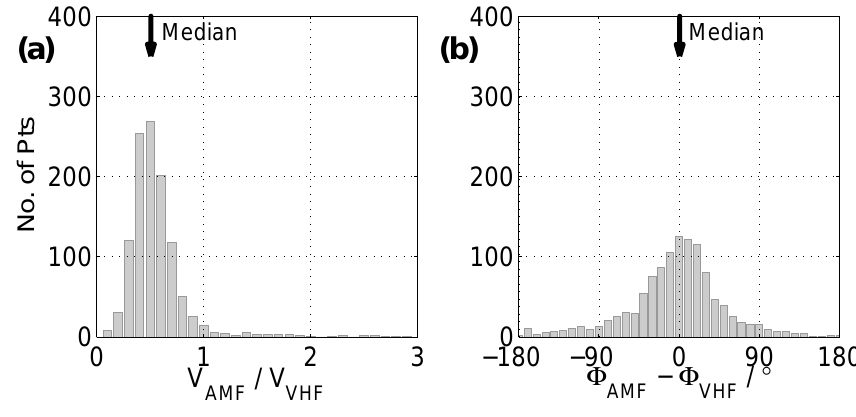
Fig. 9. Histogram of the ratios of the wind speeds (a) and differences of the wind directions (b) between Andenes MF and ALWIN VHF radars in the altitude range of 82 and 86km (July